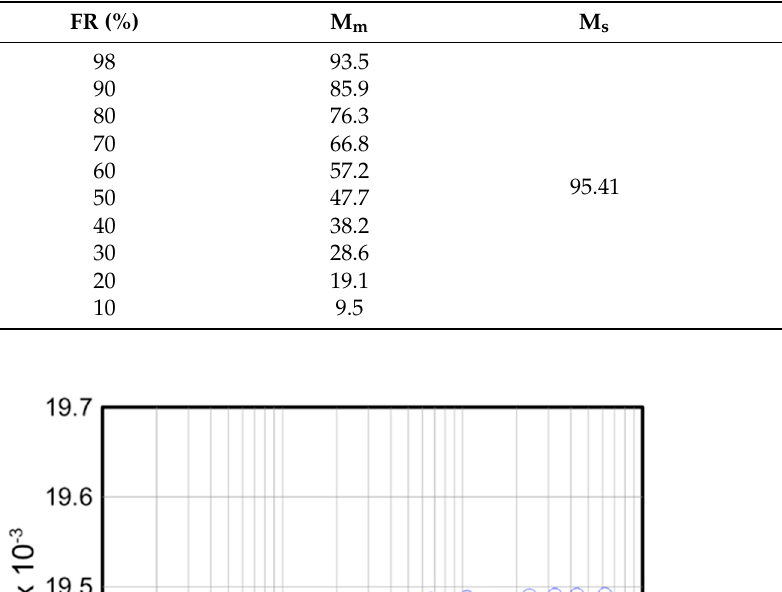
Table 4. Test results of BOR experiment.